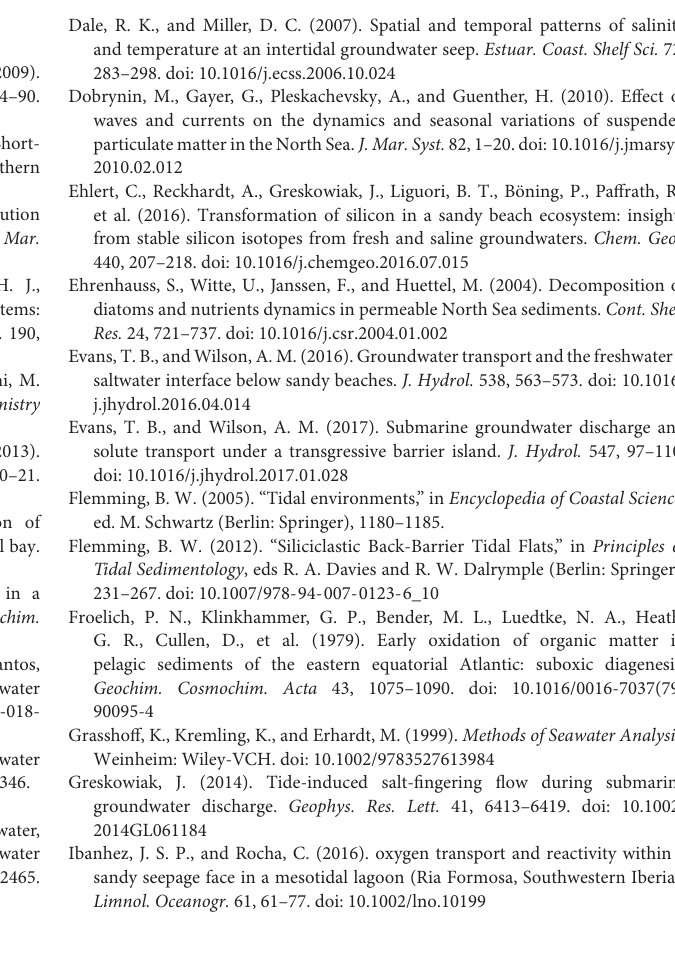
FIGURE S5 | Flux calculations for Fe(II) and FDOM using pore water data from 100 cm depth. Left panel: definition of infiltration and exfiltration zones for the three campaigns. HWL, High water line (infiltration zone); Runnel Ex1, upper part of runnel (exfiltration zone, 3.15 m 3 d − 1 m − 1 shoreline); Runnel Ex 2, lower part of runnel (exfiltration zone, 0.85 m 3 d − 1 m − 1 shoreline), Ridge (infiltration zone); LWL FIGURE S6 | Scatter plot of FDOM concentrations vs. salinity for all three campaigns and all depths. Circles denote 50 cm depth, squares denote 100 cm depth. Fe(II) concentrations are color-coded onto the symbols, with darker colors indicating higher Fe(II)